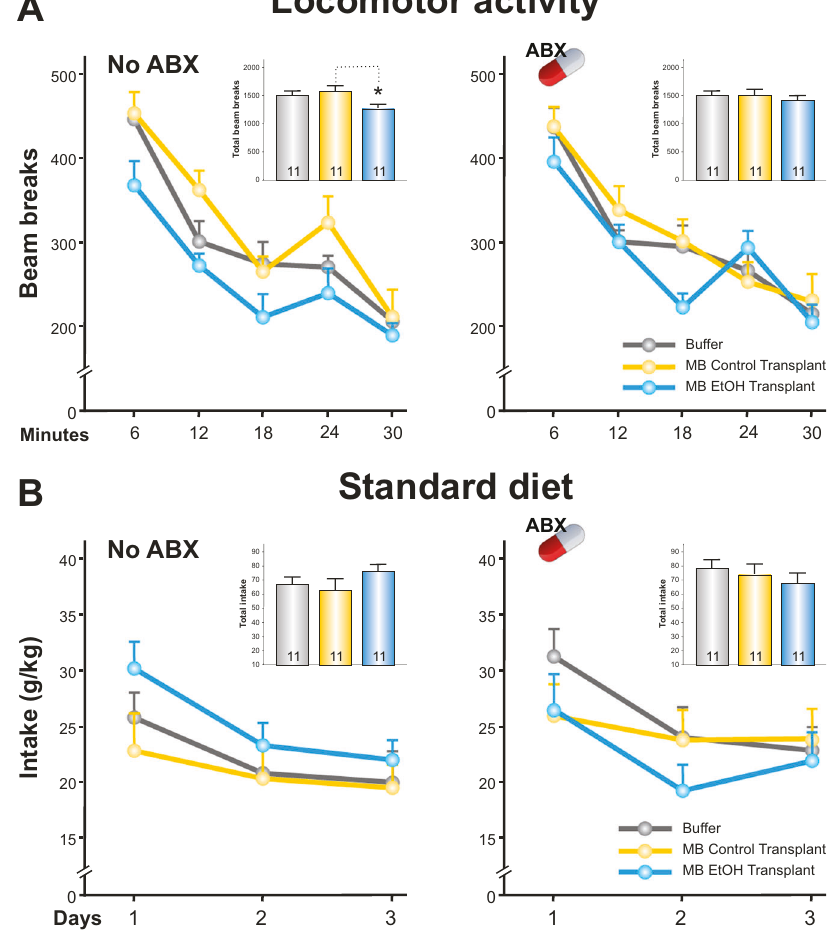
Fig. 4 Evaluation of locomotor activity. Animals that received a microbiota transplant of animals treated with alcohol showed a reduction in their locomotor activity ( A ). This effect was not observed in the group of animals that was previously treated with antibiotics. There was not a signi fi cant difference in the intake of the standard diet ( B ). * p < 0.05 compared to MB Control Transplant group. All the graphs represent mean ±